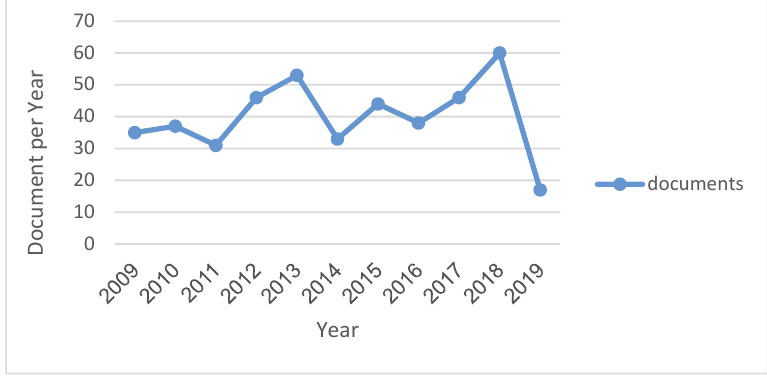
Fig. 4. Documents by years